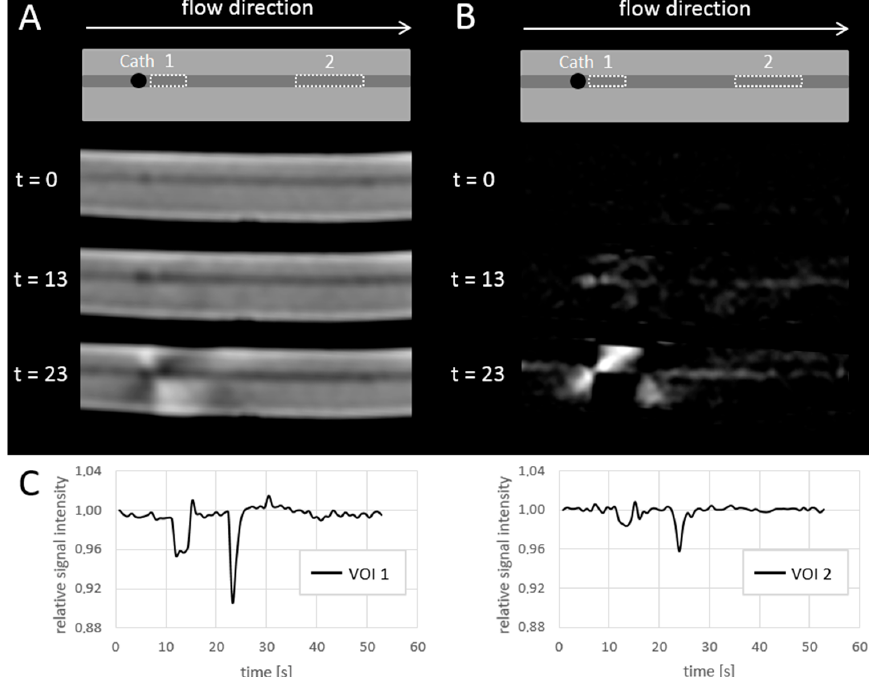
Figure 6. Intensity measurements over time in the flow phantom, during the injection of 100 mg/mL holmium-165 microspheres with flow set to 50 mL/min. ( A ) A schematic overview (top) of the images acquired, C = catheter tip, dotted lines indicate 2 VOIs used for signal quantification. Underneath, acquired images are shown at 3 different time points. ( B ) Subtraction images corresponding to the different time points of A, which more clearly visualize the signal loss induced by the microspheres. ( C ) illustrates the relative mean intensity per VOI over time. The first drop in intensity (t = 13 s) is a spill of microspheres after loading the catheter, and the second drop in intensity (t = 23 s) is flushing of the catheter with saline.